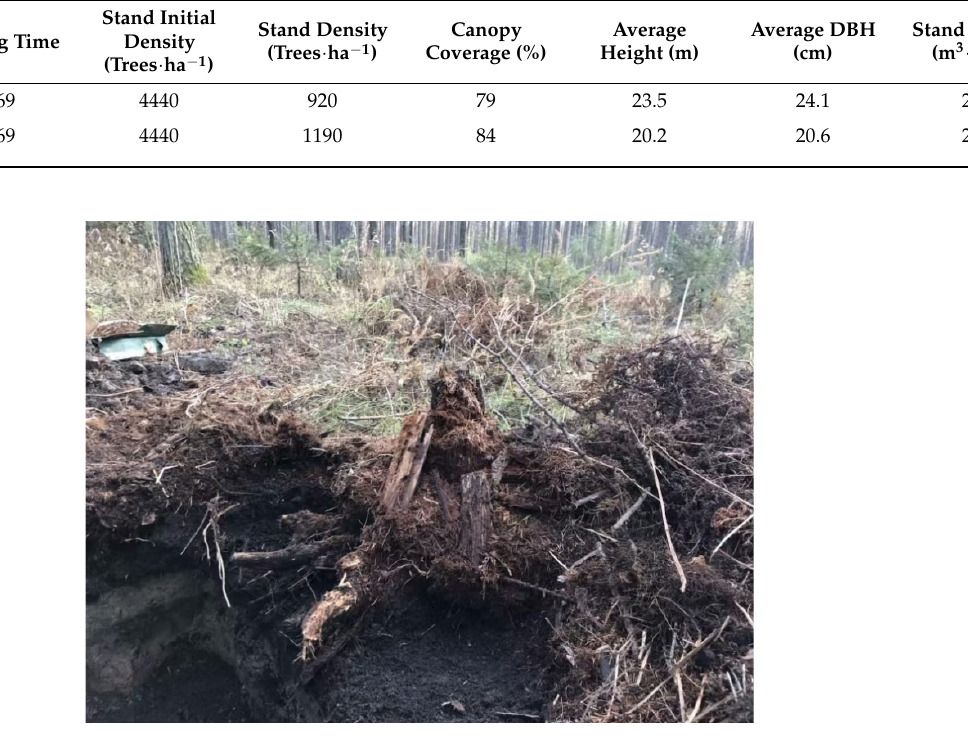
Figure 3. Illustration of the soil sampling design for each stump and coarse root. H denotes the depth of the soil layers, 0–10 cm, 10–20 cm and 20–40 cm. D1, D2, D3, D4 and D5 denote sampling points within horizontal distances of 5–15 cm, 25–35 cm, 45–55 cm, 65–75 cm and 85–95 cm from the stump and coarse root, respectively. Table 1. Basic characteristics of pure larch plantation and mixed larch–ash plantation. Stand Types Planting Time